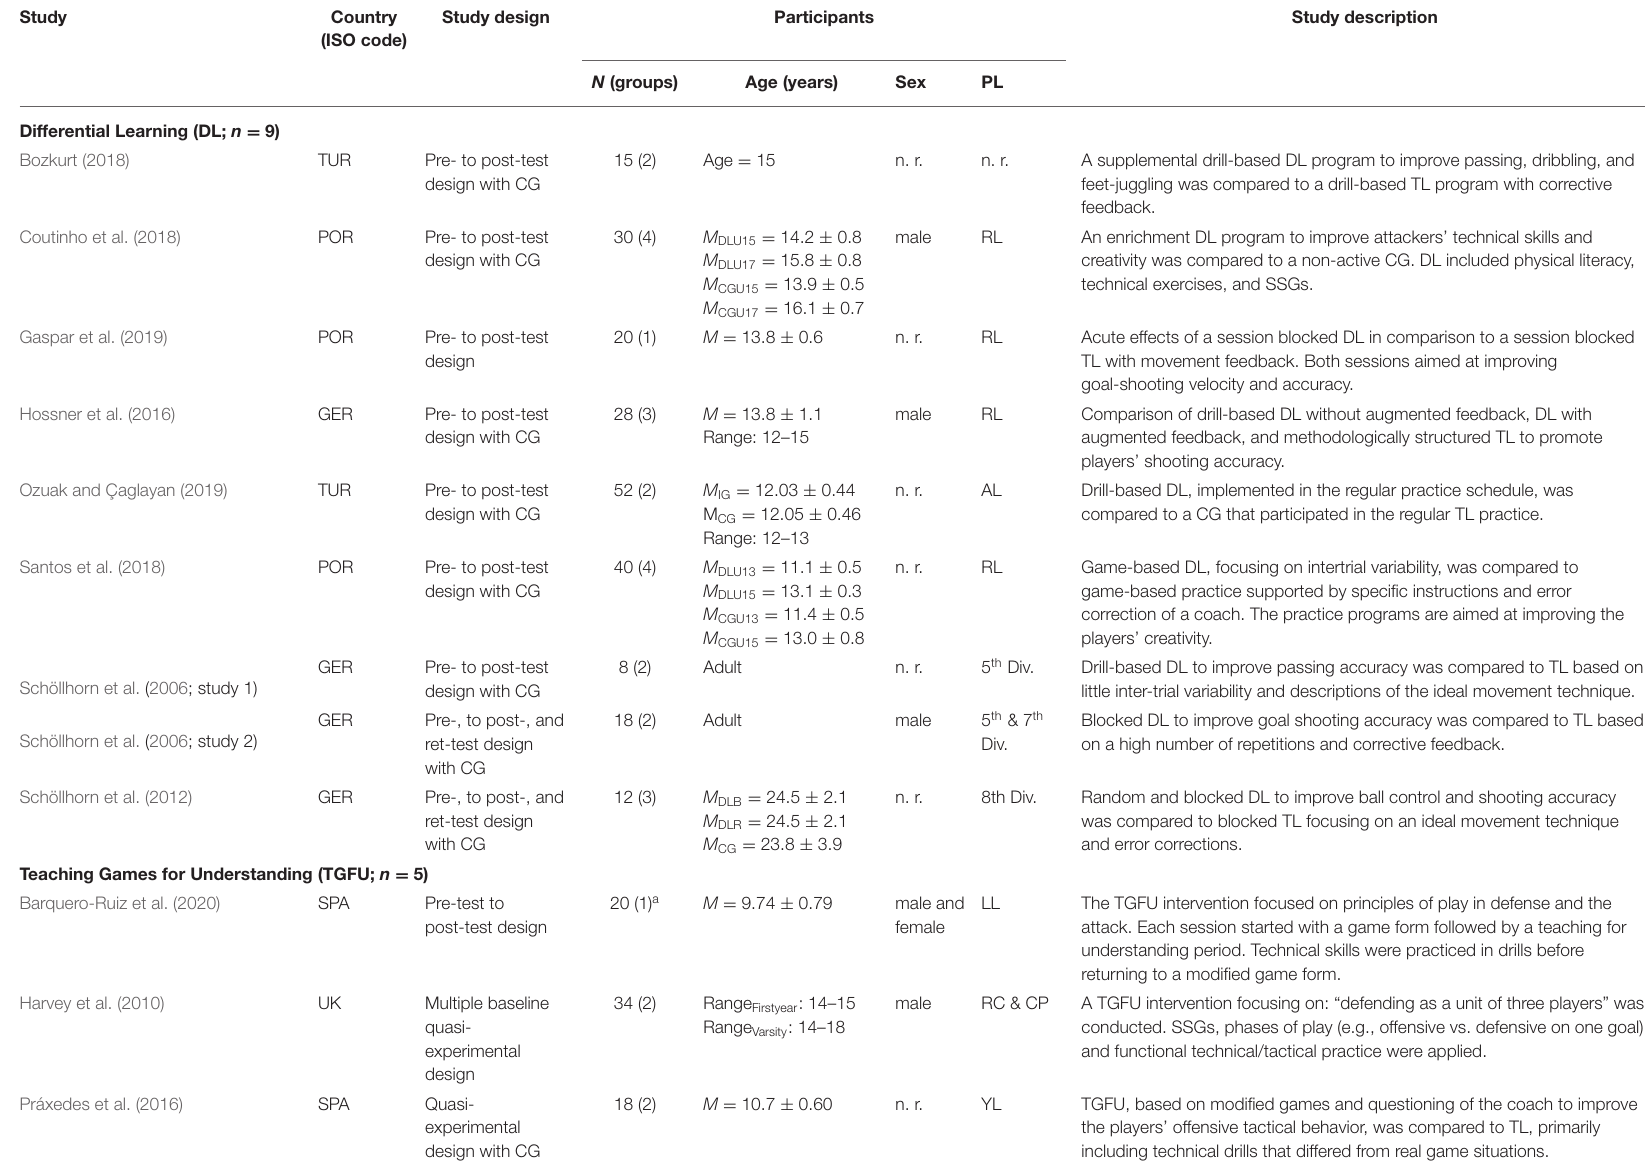
TABLE 2 | Characteristics of studies investigating theory-driven instructional approaches to practice and coaching ( n =